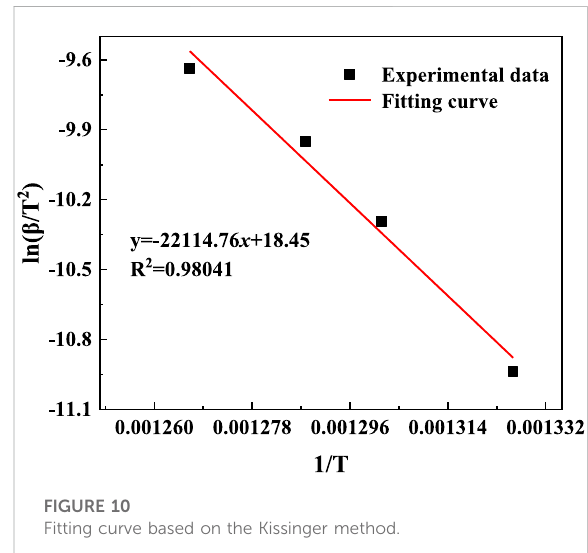
FIGURE 10 Fitting curve based on the Kissinger method.